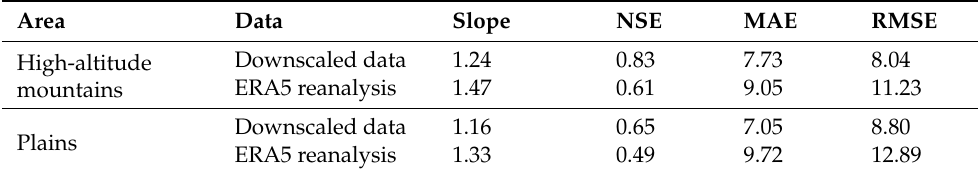
Table 4. Accuracy comparison of downscaled dataset and ERA5 reanalysis.